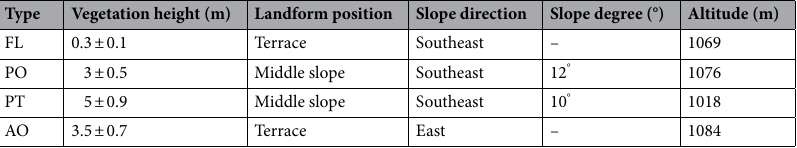
Table 1. Basic characteristics of the experimental sites (mean ± SD, n = 2). FL farmland, PO Platycladus orientalis (Linn.) Franco, PT Pinus tabulaeformis Carr., AO apple orchard, – data not